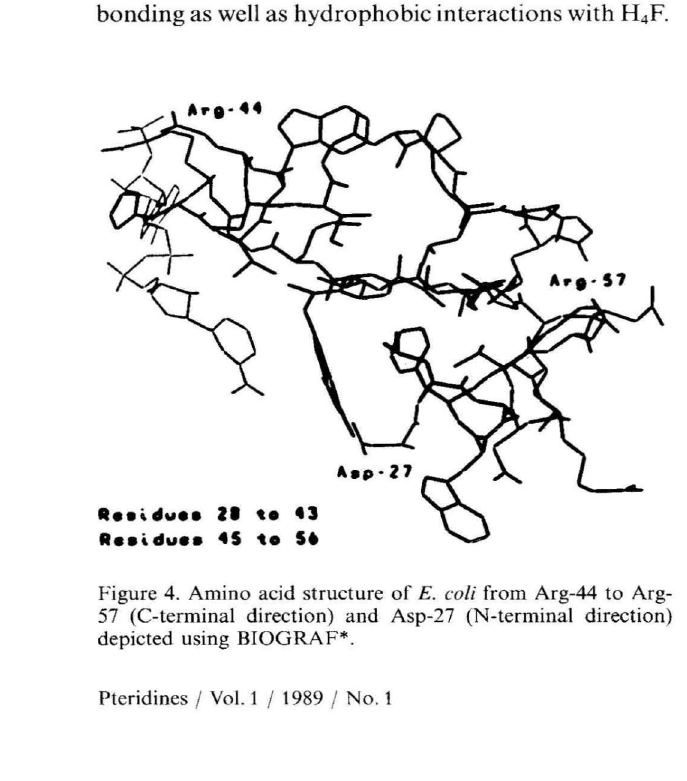
Figure 4. Amino acid structure of E. coli from Arg-44 to Arg- 57 (C-terminal direction) and Asp-27 (N-terminal direction) depicted using